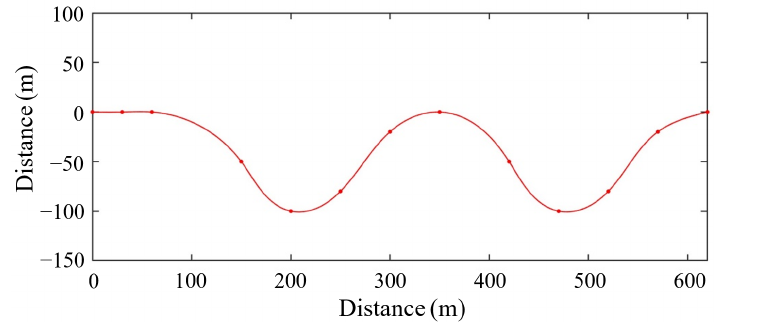
Figure 14. Curved road model.